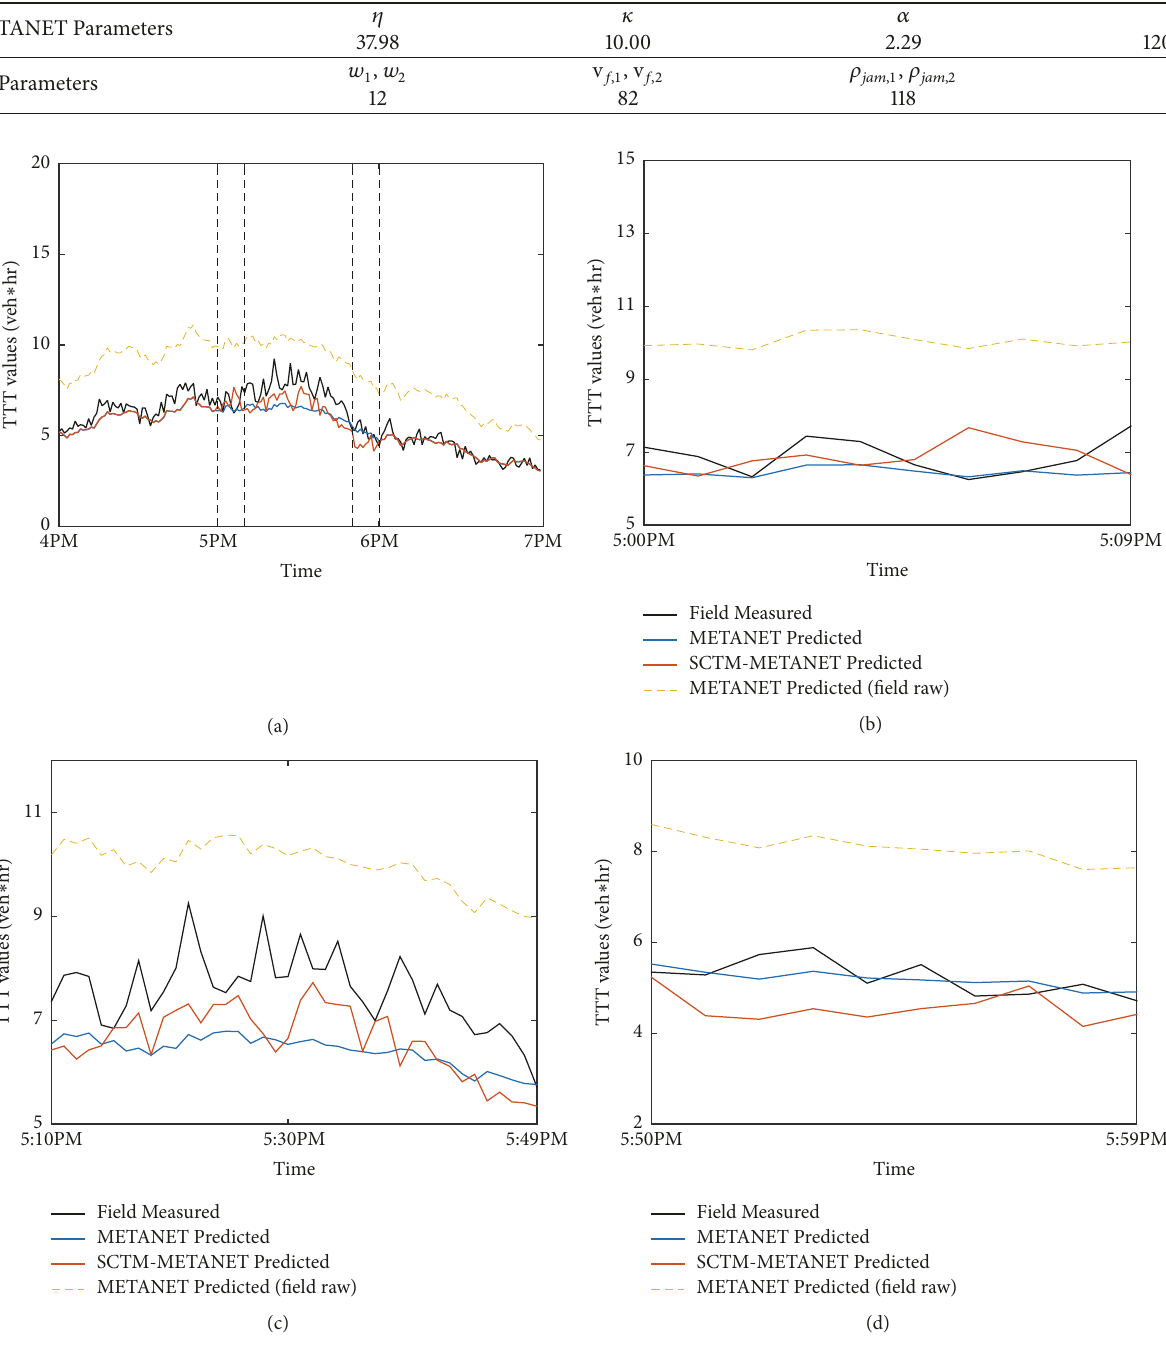
Table 1: Parameters used in the field test.